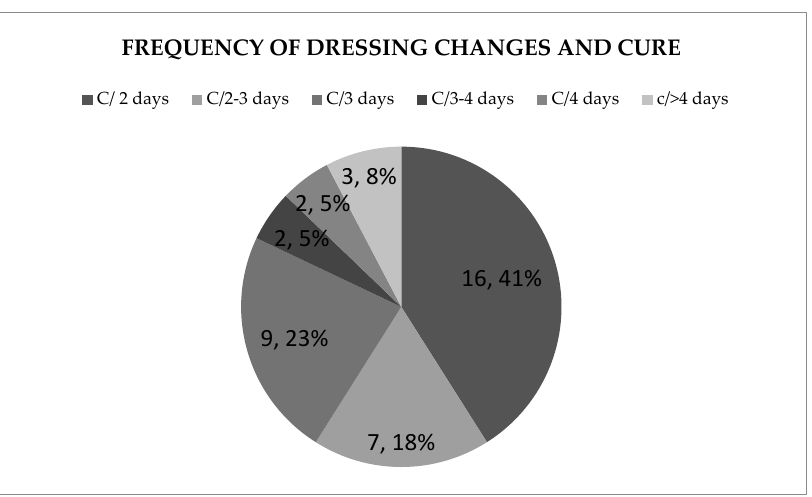
Figure 2. Percentage of cases that coincide on the days on which cures and dressing changes are